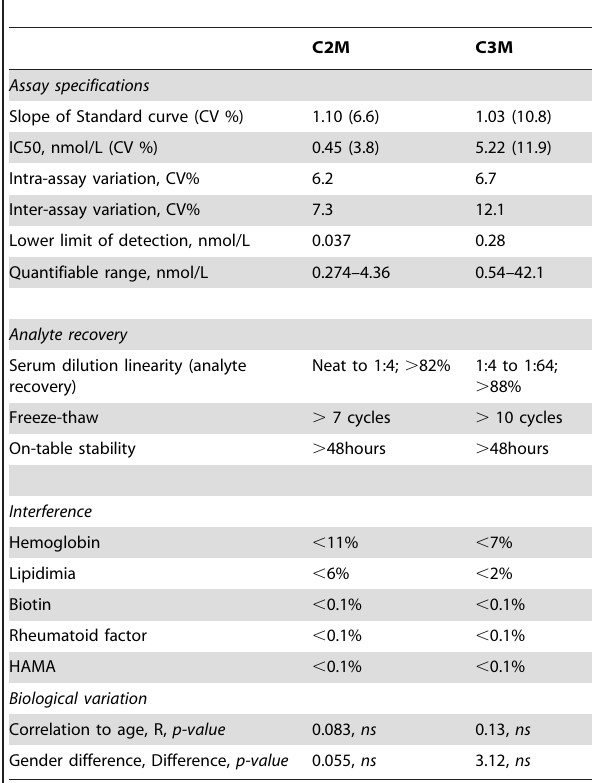
Table 2. ELISA technical performance.